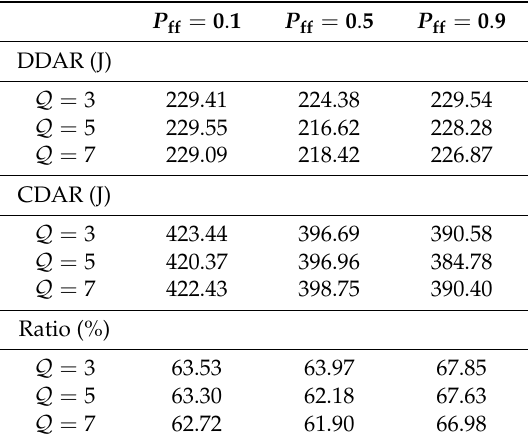
Table 8. Average maximum energy consumption and the ratio vs. P α